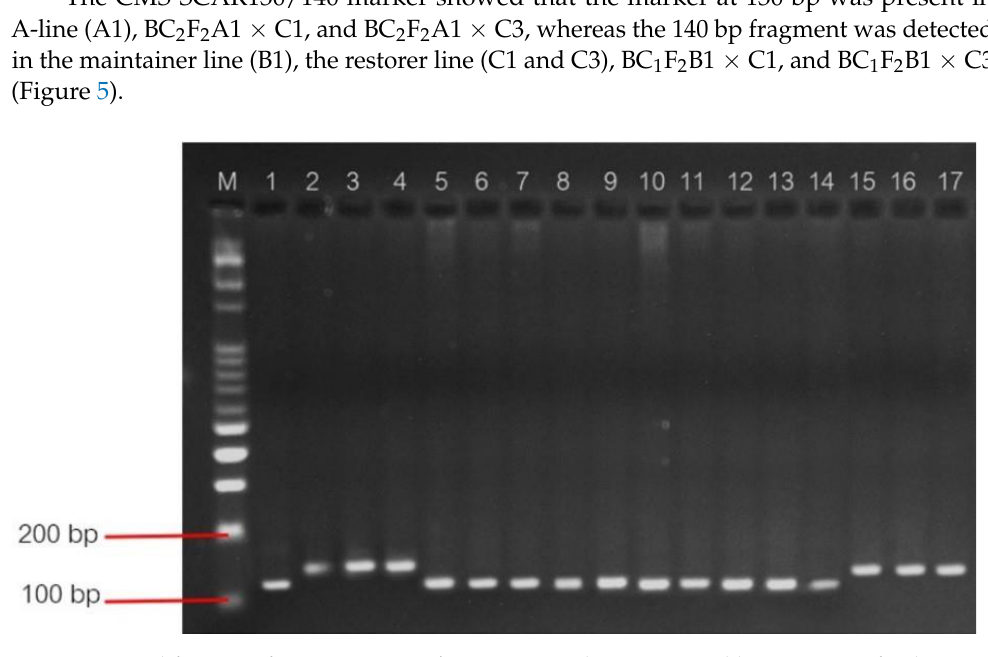
Figure 5. Amplification of CMS-SCAR130/140 DNA marker in parental lines, BC 2 F 2 of A-line